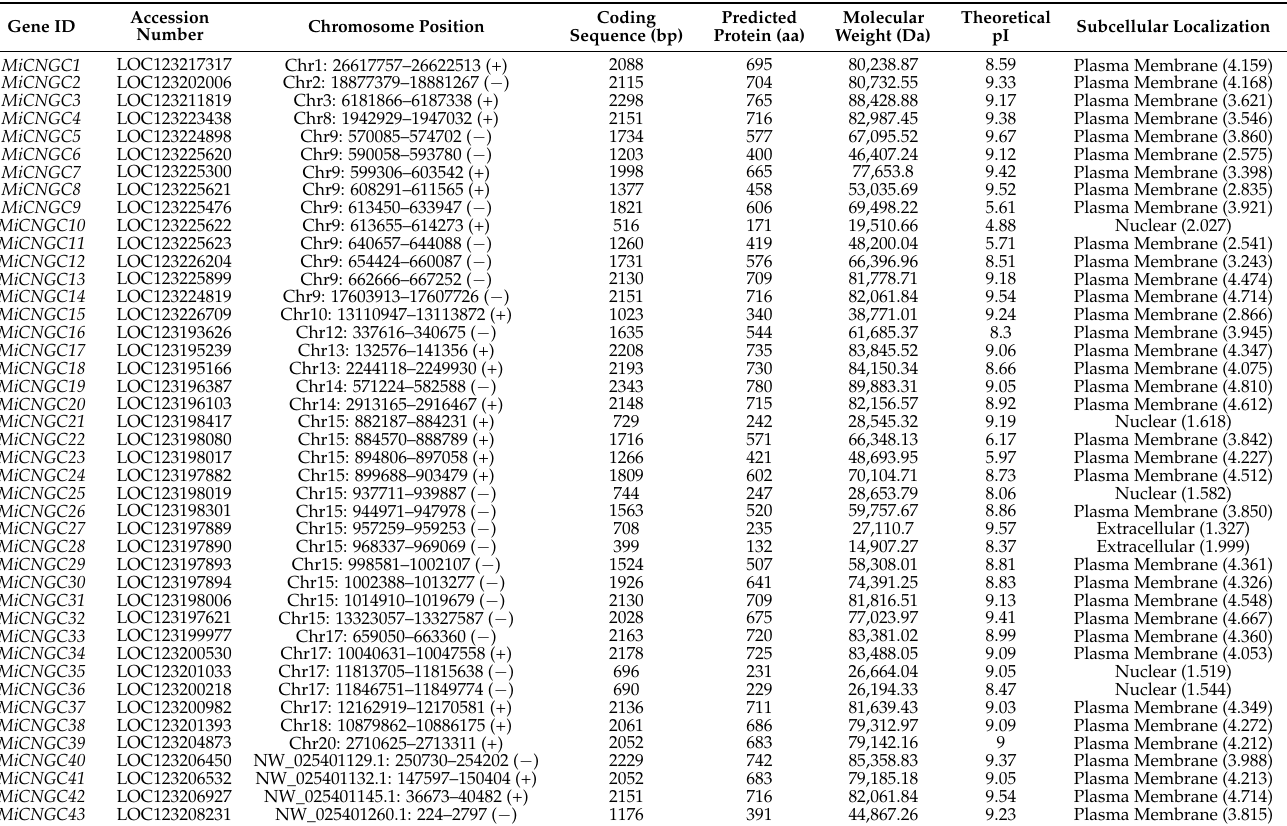
Table 1. Characterization of mango CNGC genes, including their accession numbers, chromosome positions, the lengths of coding sequences and predicted proteins, pI and subcellular